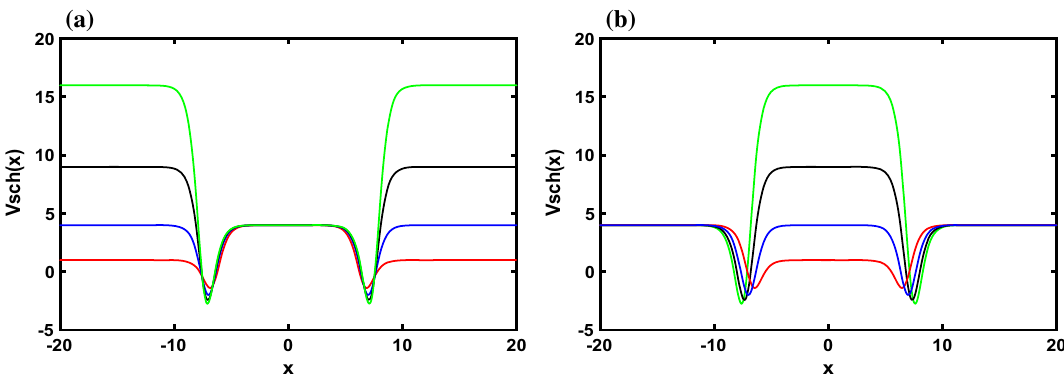
Fig. 4 Schrödinger potential V sch ( x ) for a kink-antikink φ ( 0 , 1 ) n ( x + x 0 ) + φ ( 1 , 0 ) n ( x − x 0 ) − 1 and b antikink-kink φ ( 1 , 0 ) n ( x + x 0 ) + φ ( 0 , 1 ) n ( x − x 0 ) . In all figures x 0 = 8. We fixed n = 1 (red solid), n = 2 (blue solid), n = 3 (black line) and n = 4 (green